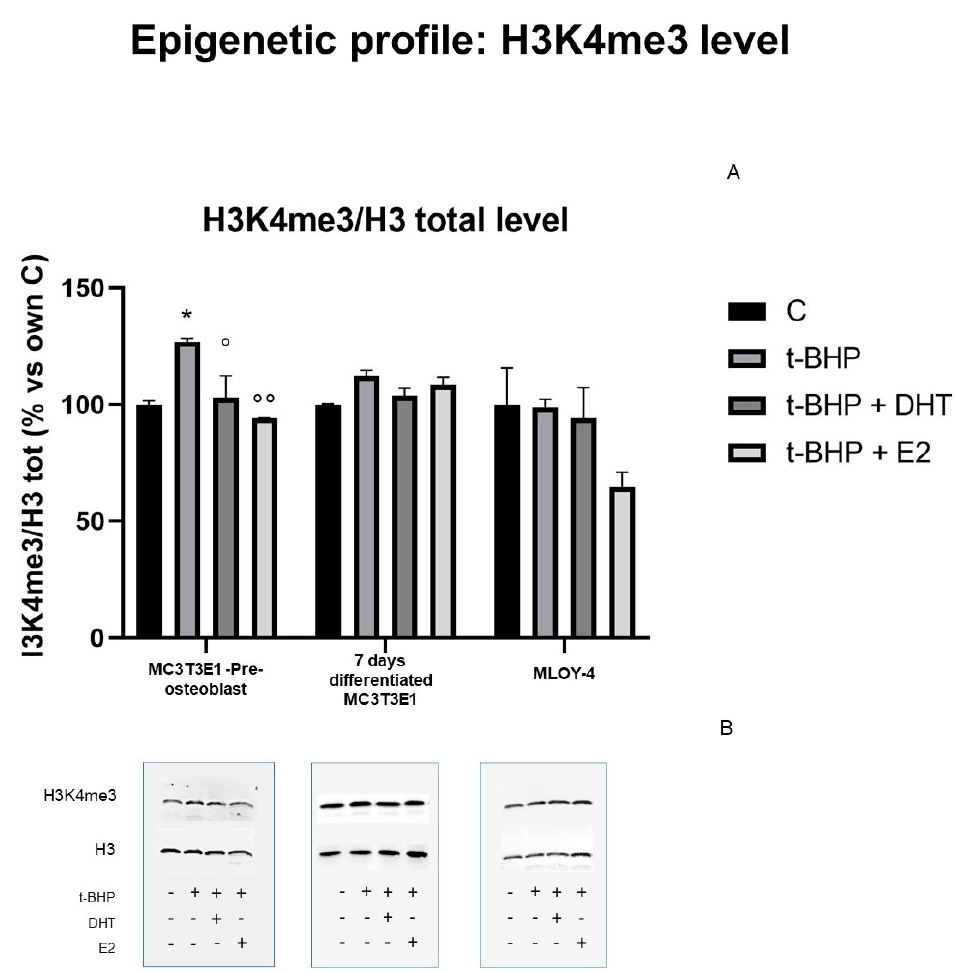
Figure 7. Effects of oxidative stress and steroids on H3K4me3. Effects of exposure to t-BHP (250 µ M in pre-osteoblastic cells, 125 µ M in 7-day-differentiated cells and osteocyte-like cells, MLOY4) and steroids (10 − 9 M) on H3K4me3. ( A ): densitometric analysis from Western blot analysis for H3K4me4. The signal from H3K4me3 was normalized against the total histone H3. t-BHP exposure only induces H3K4me3 in pre-osteoblasts and steroids treatment (more consistent for E2) restores the basal condition. ( B ) Representative Western blot for H3K4me3 and total histone H3. Data are represented as the mean ± SEM of three replicates within a single experiment. The experiment was repeated twice. Differences between groups were evaluated by one-way ANOVA, followed by Bonferroni post-hoc test. * p < 0.05 vs. control, ◦◦ p < 0.01 vs. t-BHP, ◦ p < 0.05 vs.